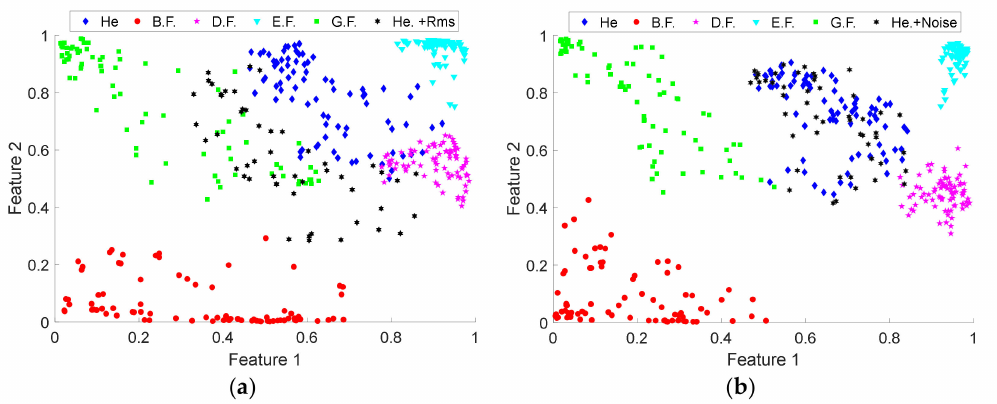
Figure 11. Projection of the extracted set of features resulting for: ( a ) each of the considered conditions and the healthy condition with a modified RMS (He. + RMS), ( b ) each of the considered conditions and the healthy condition with added noise (He. +